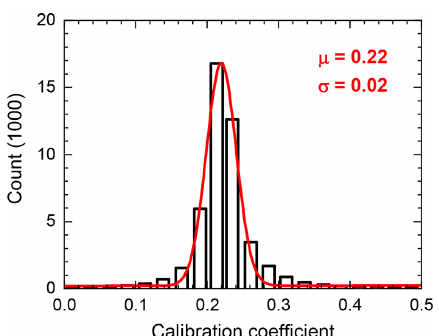
Figure 5. Determination of the calibration coefficient for the RAM- SES measurements on 21–22 August 2021. Distribution of the cal- ibration coefficient (bars) and its Gaussian fit (curve) is shown. µ – mean, σ – standard